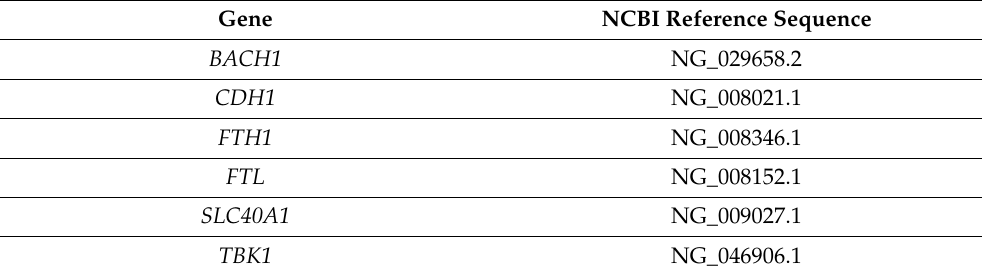
Table 3. DNA sequences of genes analyzed. Gene NCBI Reference